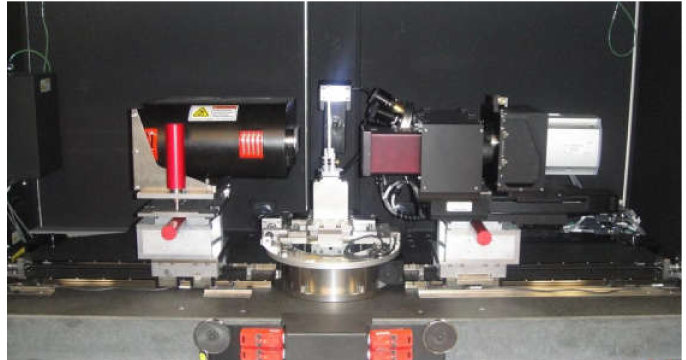
Figure 2. The Xradia X-400 Micro-CT industrial imaging suite used in the case study. This setup contains an X-ray source (left component), the stage for positioning the sample and region of interest (center) and an X-ray detector for obtaining transmitted photons that have passed through the sample (right component). The X-ray detector features a turret with multiple objectives at di ff erent magnifications. Namely, 4 Megapixel (2048 × 2048) 16-bit digital CCD camera (Andor DW436-BV-550) incorporated five microscope objectives (0.39 × , 1 × , 40 × , 10 × and 20 × ) with